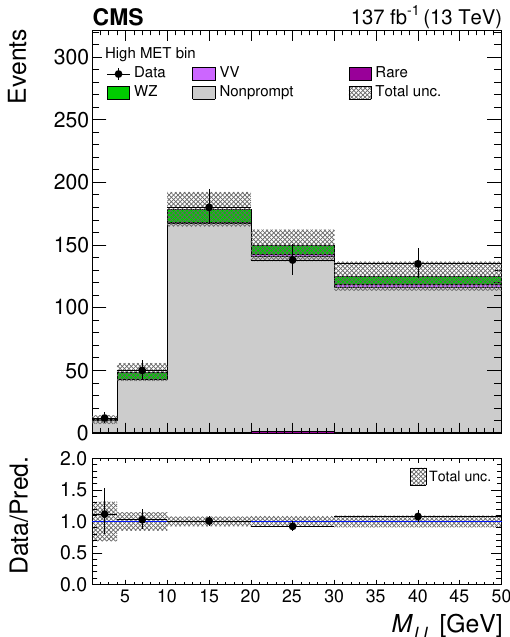
Figure 4 . The post-fit distribution of the M ( ‘‘ ) variable is shown for the high-MET bin for the SS CR. Uncertainties include both the statistical and systematic